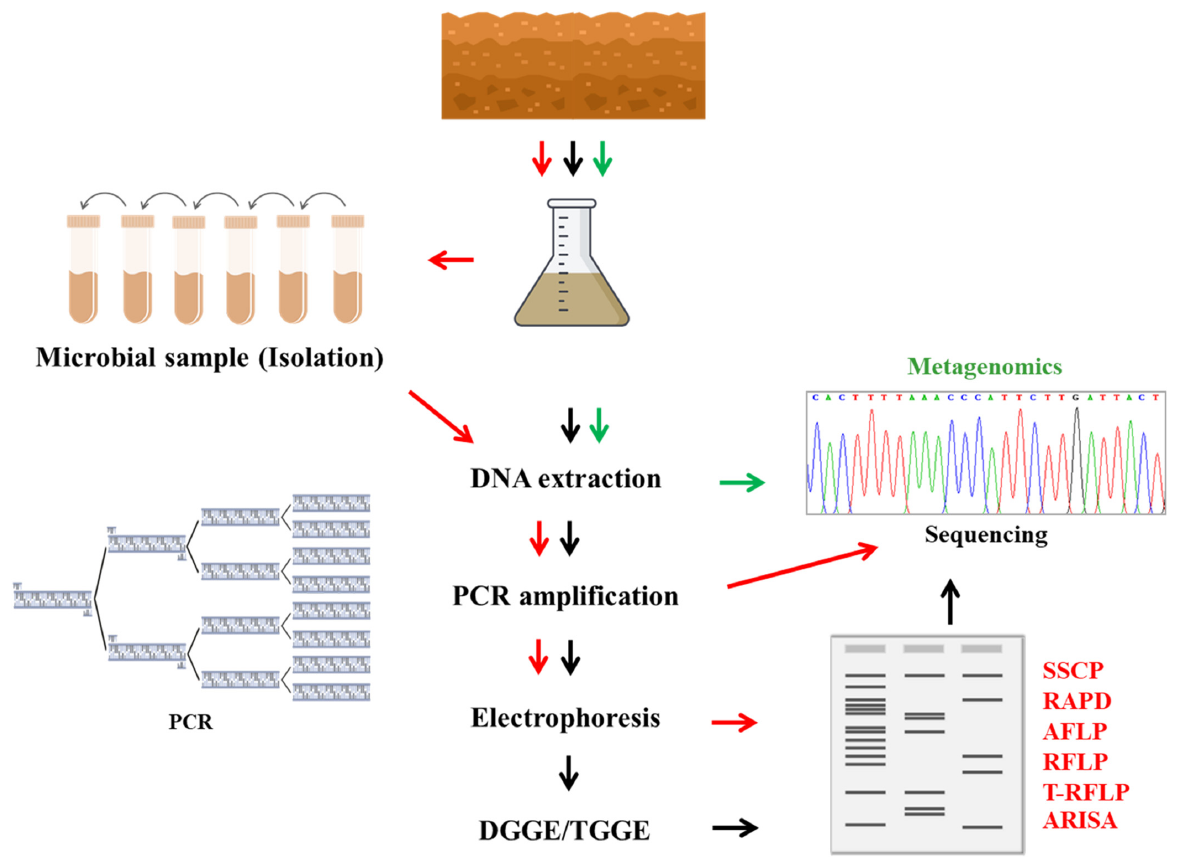
Figure 2. Microbial diversity study from isolation of microbes to metagenomics. SSCP = Sin- gle-strand conformational polymorphism, RAPD = Randomly amplified polymorphic DNA,